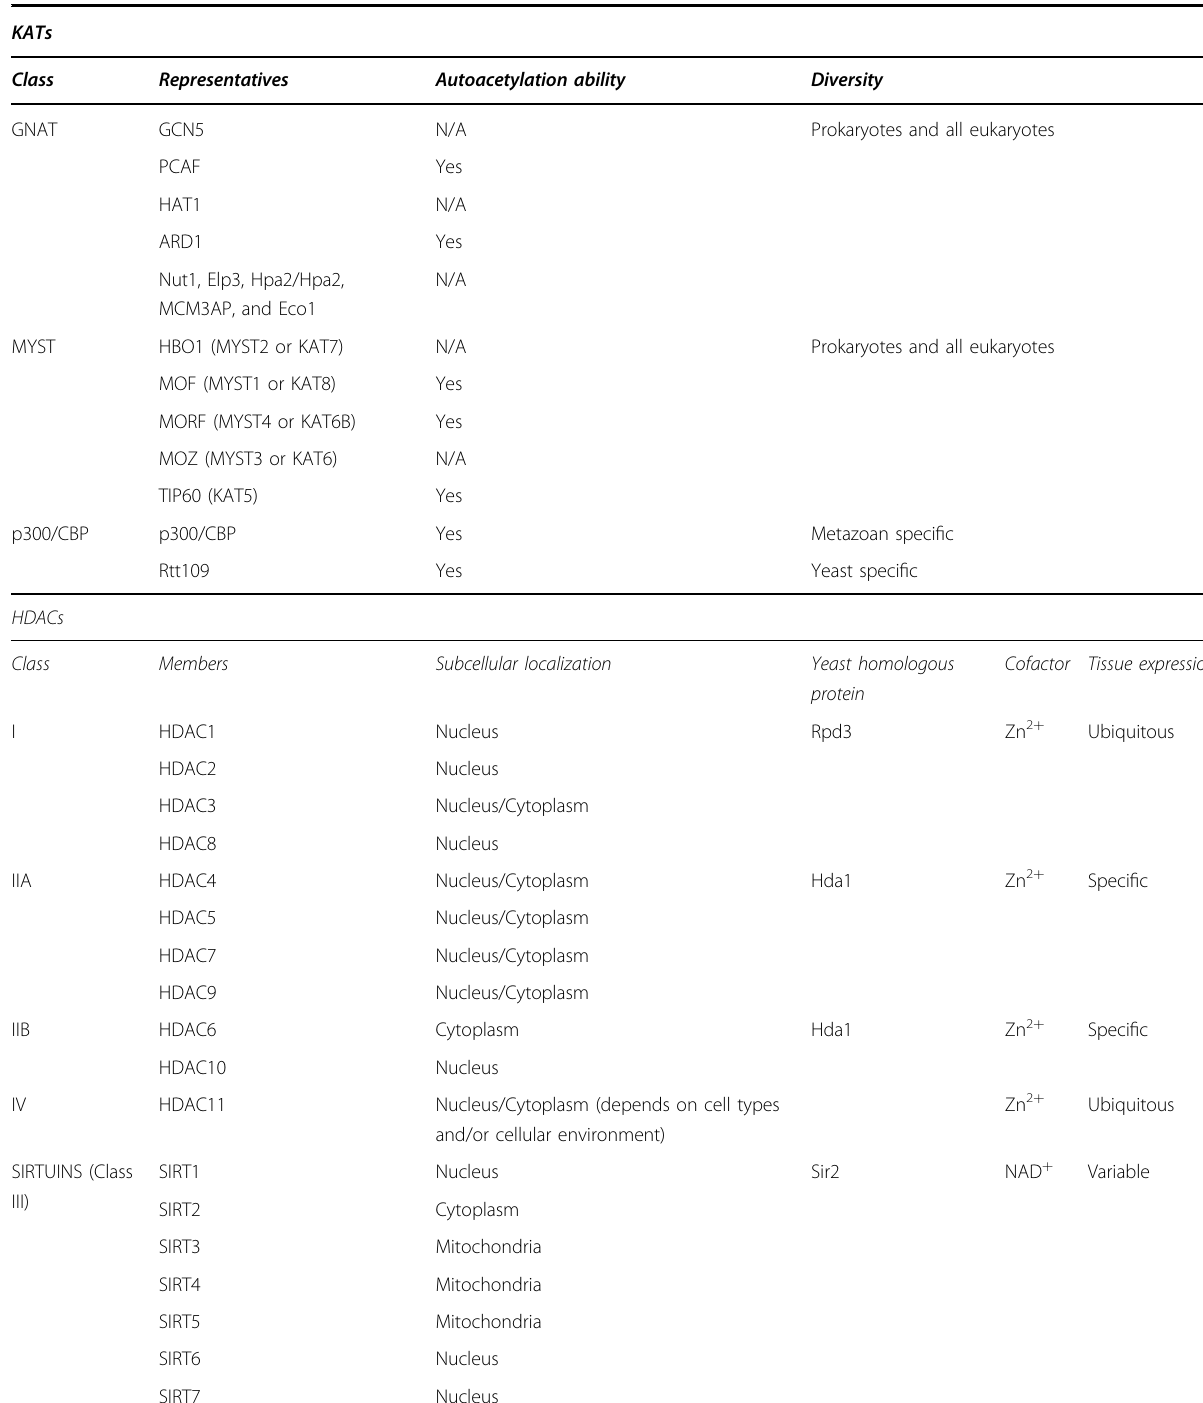
Table 1 Classi fi cation and properties of lysine acetyltransferases and histone deacetylases